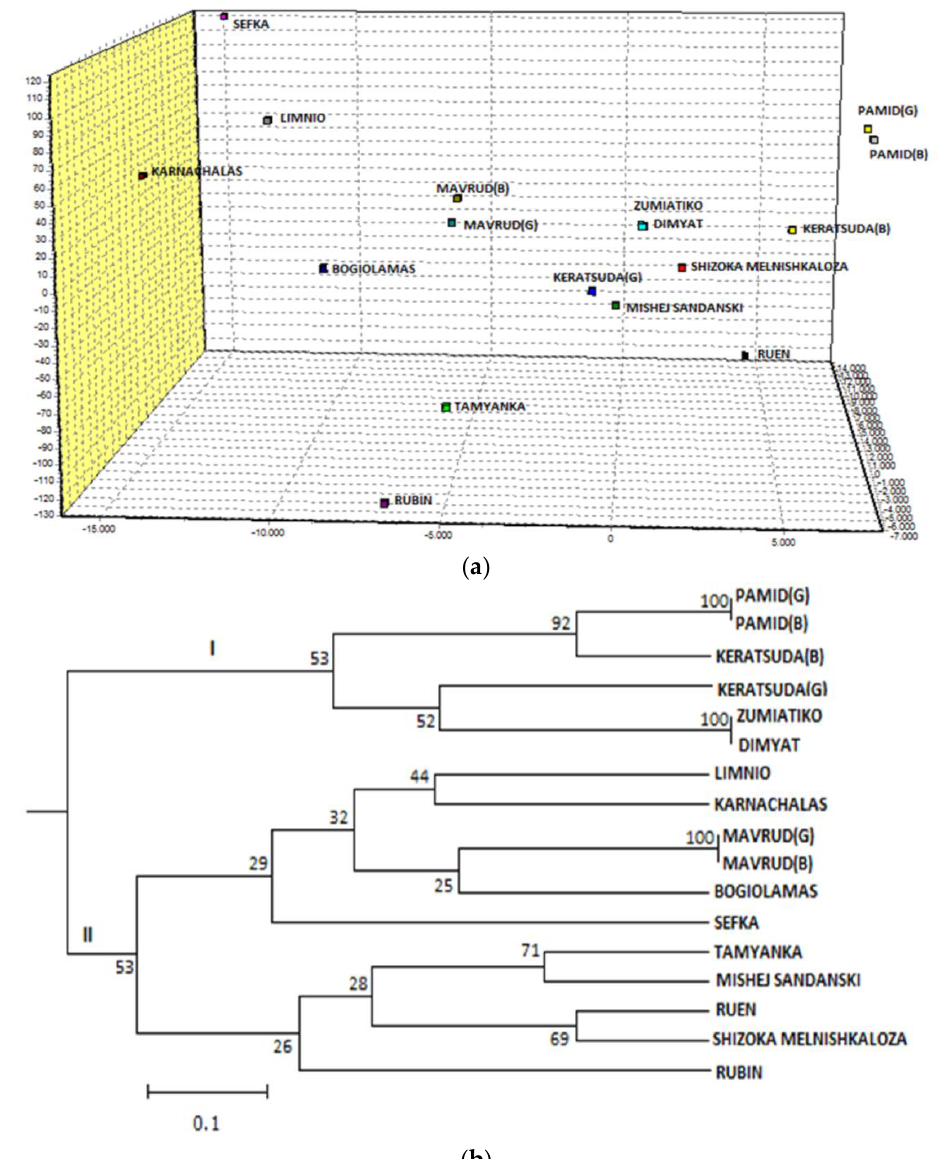
Figure 1. Factorial correspondence analysis of all Greek and Bulgarian grapevine varieties under study, using the Genetix 4.05.2 software ( a ); unweighted pair group method with arithmetic mean (UPGMA) dendrogram of all studied varieties constructed with the POPTREEW package, comprised of two major clusters (I and II). Numbers in nodes represent bootstrap values ( b ).